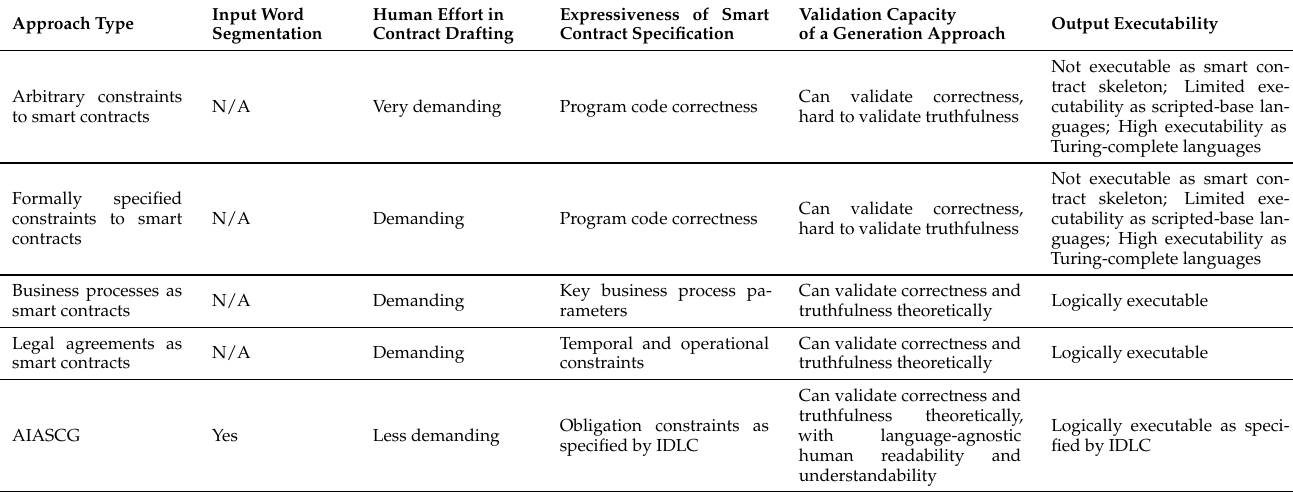
Table 2. Comparison of smart contract generation